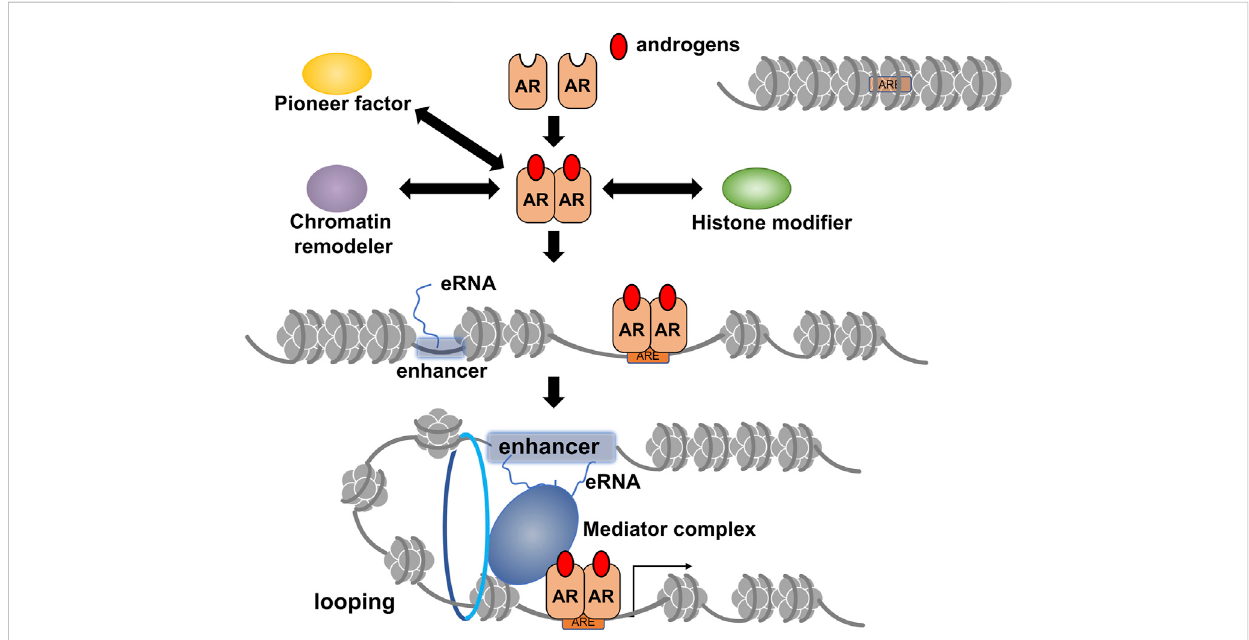
FIGURE 2 A schematic of ligand-dependent gene regulation by androgen receptor (AR) through epigenetic modi fi cations and chromatin reorganization. The AR target site surrounding inactivated chromatin array is opened through chromatin remodeling by the activities of chromatin remodelers, histone modi fi ers, and pioneer factors, such as forkhead box A1 (FOXA1). Details of chromatin remodelers, histone modi fi ers, and transcriptional co-regulators involved in androgen-induced gene regulation by AR are described in Table 1. Formation of chromatin looping is induced for ef fi cient transcription by activated AR, and enhancer RNA transcribed from potent enhancers, such as super-enhancer (SE), facilitates this process. Notably, it is currently unclear whether chromatin opening for AR DNA binding is associated with the eRNA-induced formation of chromatin